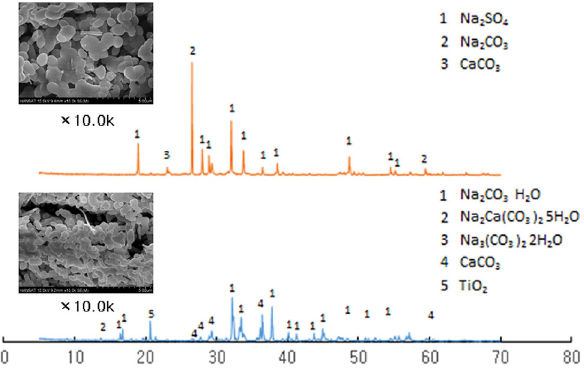
Fig. 12 XRD analysis results of the efflorescence